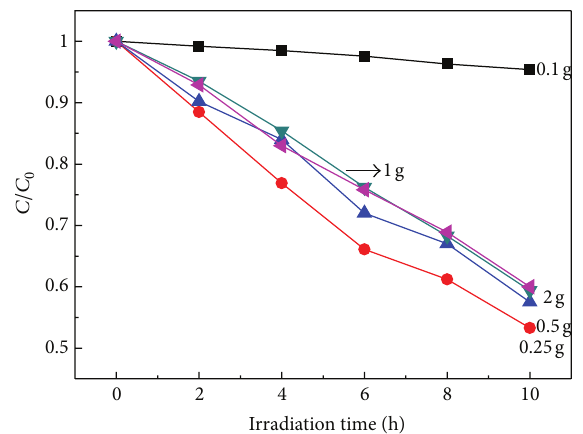
Figure6:EffectsofN-dopedTiO 2 powdersloadonthephotodegra- dation of phenol at pH = 6